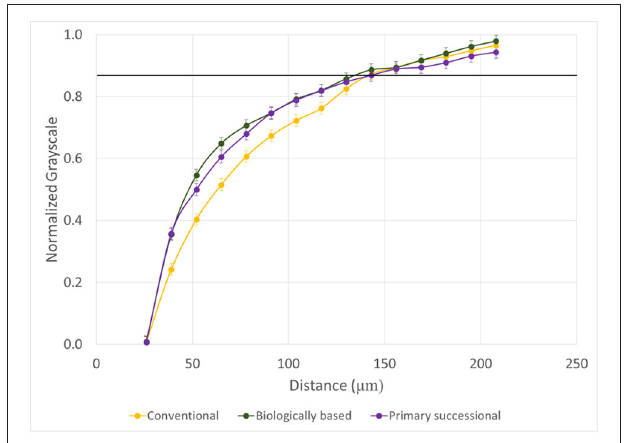
FIGURE 10 | Percentage of 2–13 µ m pores as a function of distance from pores of biological origin with plant roots (POM-Root) and with non-root derived POM (POM-NS) and from non-biological pores ( n = 8). Error bars are standard errors at each